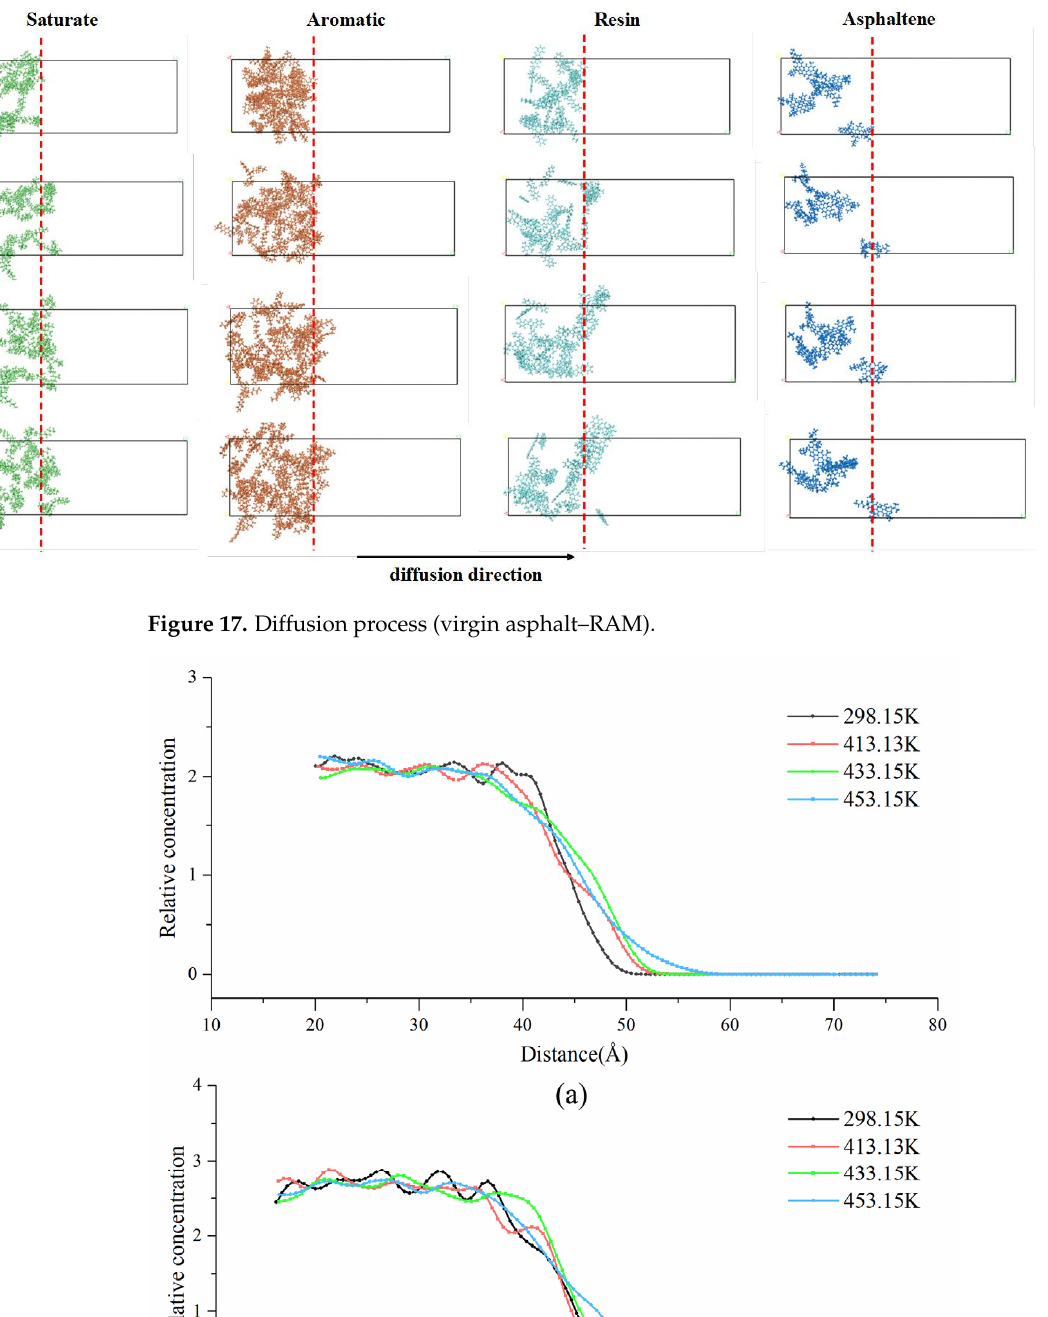
16 of 20 Figure 16. Binding energies of virgin–aged asphalt and virgin asphalt–RAM at di ff erent tempera- tures. 3.3.2. Mutual Di ff usion Coe ffi cient The di ff usion behavior for virgin asphalt–RAM is one of the key points to determine whether a homogeneous recycled asphalt can be achieved. The di ff erence in concentration between the two regions will cause mutual di ff usion at the molecular level. If the concen- trations are equal, the interdi ff usion process ceases. Figure 17 shows the evolution of mol- ecules for virgin asphalt–RAM at 433 K during the mutual di ff usion. As shown in Figure 17, the snapshots of the model (virgin asphalt–RAM) at the simulation times of 125, 250, 375 and 500 ps are extracted. Virgin asphalt is concentrated on the left side of the simula- tion box, and the RAM is on the other side. To su ffi ciently exhibit di ff usion processes of virgin asphalt, the molecules of RAM are set to be invisible in sequence. It can be clearly